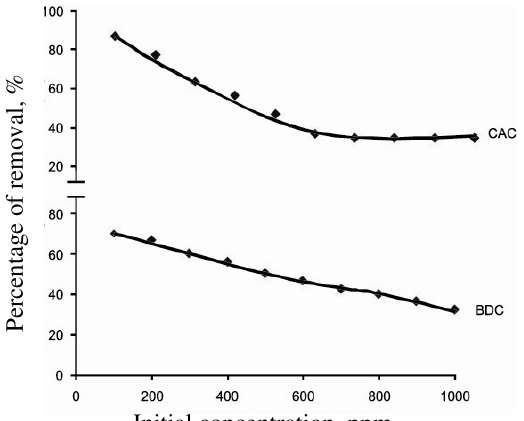
Figure 1. Effect of Initial concentration on the removal of lead(II) ions by BDC and